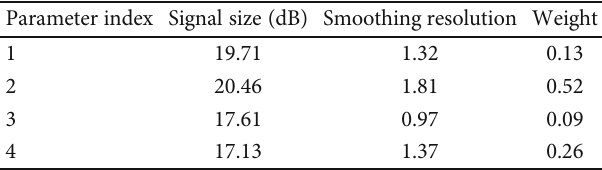
Figure 3: Two-dimensional scattered point distribution of sensitivity of extreme points of music signal. Table 1: Music signal noise smoothing parameter